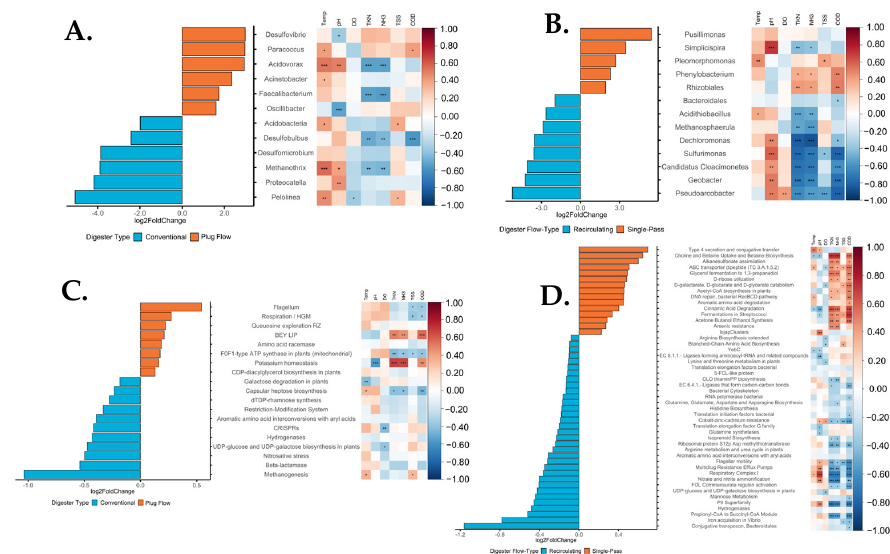
Figure 2. Pairwise comparisons with Spearman rank correlations to chemical parameters of differ- entially abundant genera in ( A ) conventional vs. plug flow-type, ( B ) recirculating and single-pass and differentially abundant functional genes in ( C ) conventional vs. plug flow-type, ( D ) recirculating and single-pass. Differential abundance analysis was performed using DESeq2 with an abundance cutoff of 0.1% of total agglomerated genera and subsystem Level III counts and an adjusted p -value of p < 0.001 for genera and p < 0.05 for gene counts. Significant Spearman correlations are marked with asterisks (adj. p < 0.05), where “***” 0.001, “**” 0.01, “*” 0.05.